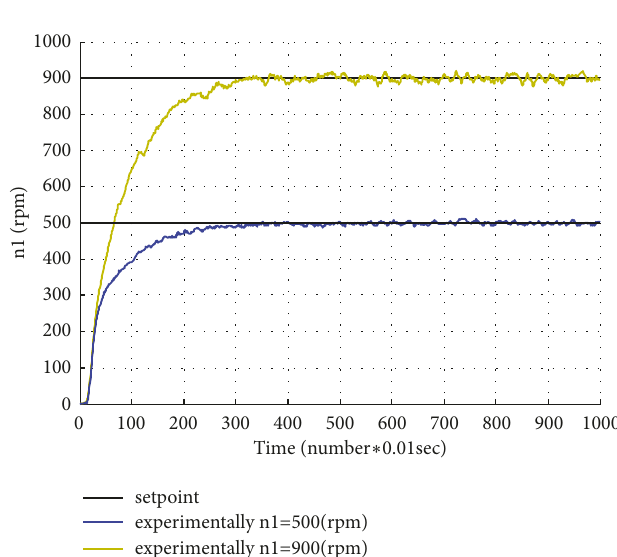
Figure 14: Velocity respone of the working shaft.